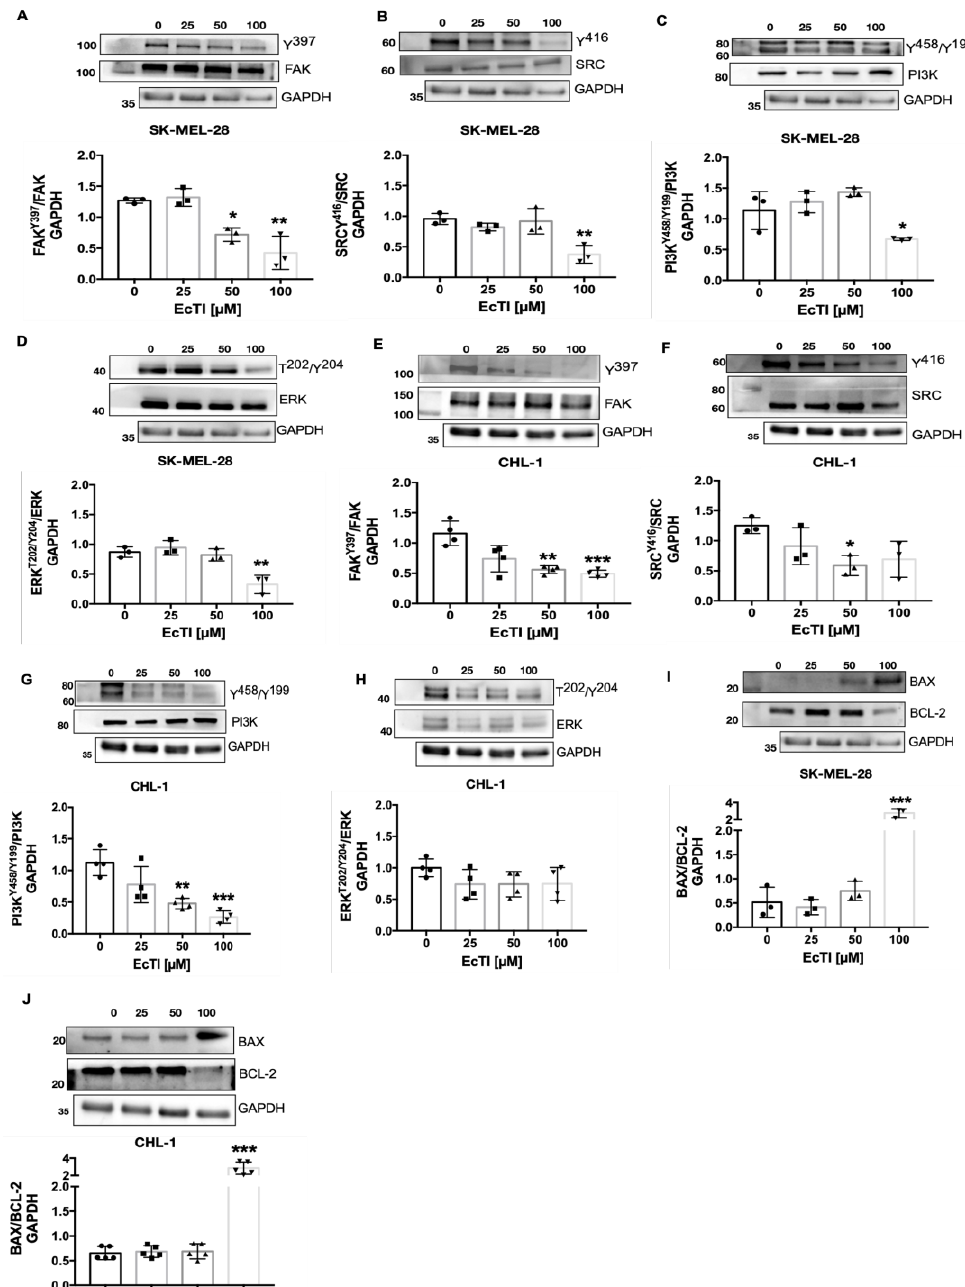
Figure 5. Survival and apoptotic-related proteins. The action of EcTI on different proteins related to cell survival and apoptosis in human melanoma cells is depicted. The proteins in panels ( A – H ) are associated with cell proliferation, migration, and invasion, while those in panels ( I , J ) are associated with cell death. EcTI interfered with FAK ( A ), SRC ( B ), PI3K ( C ), and ERK ( D ) in SK-MEL-28 cells and with FAK ( E ), SRC ( F ), and PI3K ( G ) in CHL-1 cells; however, ERK ( H ) was not affected in CHL-1 cells. Furthermore, EcTI affected the expression of the cell death protein BAX/BCL-2 in both SK-MEL-28 ( I ) and CHL-1 ( J ) cells. The graphs are provided in arbitrary units (a.u.), and all proteins except for the phospho-total ratio were normalized with the housekeeping protein, GAPDH. The control is represented by “0”. The bars represent means and SDs. Significance was considered as * p < 0.05, ** p < 0.005, and *** p < 0.0005.